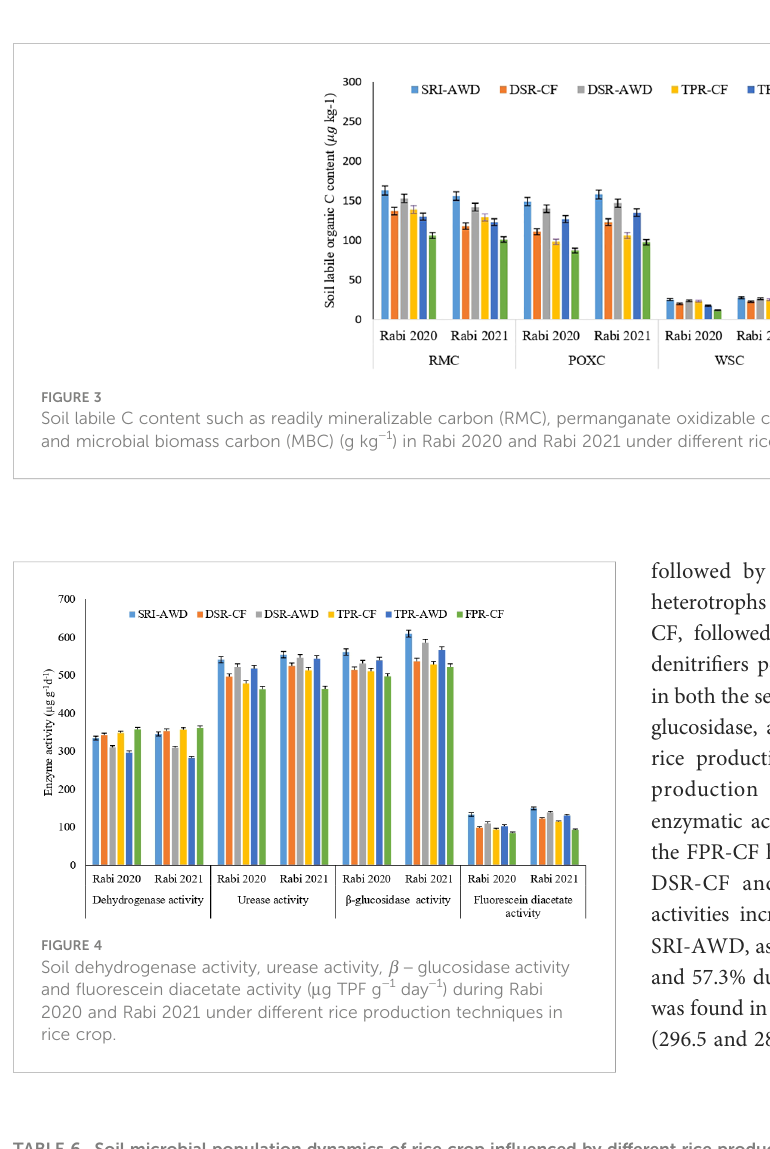
TABLE 6 Soil microbial population dynamics of rice crop in fl uenced by different rice production techniques.